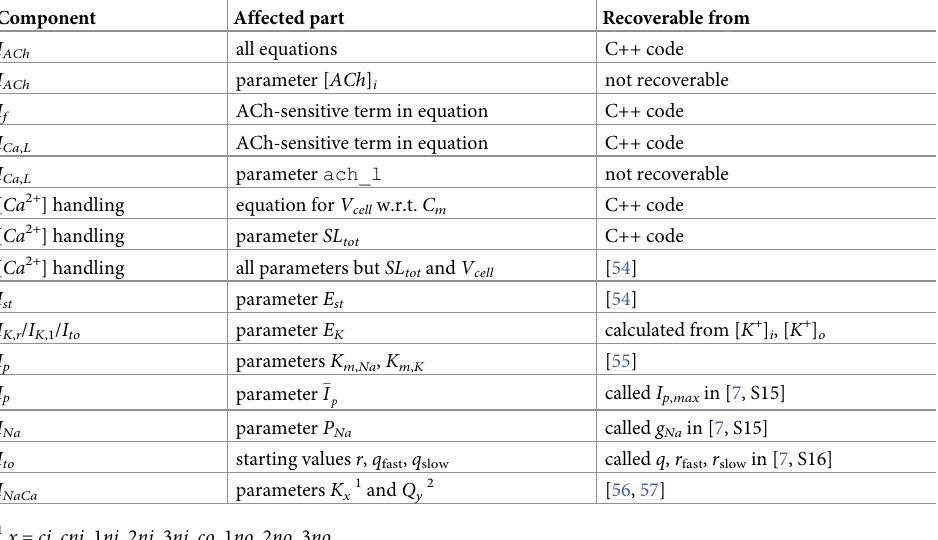
Table 1. Missing information in the Inada model including all parameters, equations and starting values that can- not be found in the original article. Component Affected part Recoverable from all